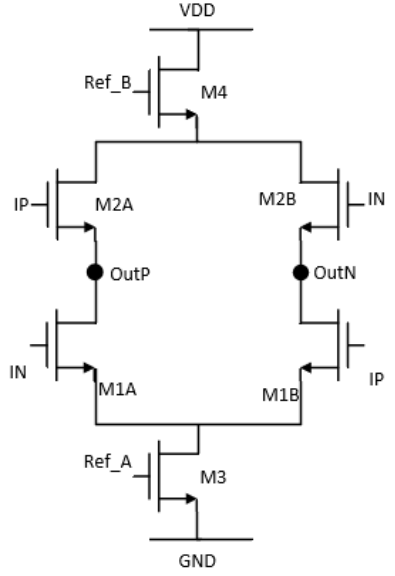
Figure 10. SLVS driver H-bridge transistor-level